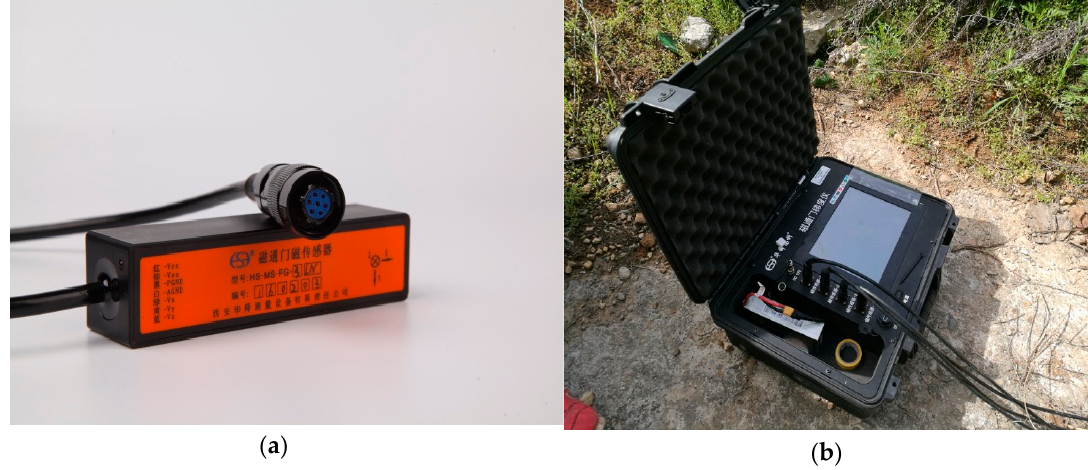
Figure 15. ( a ) Three-component fluxgate sensor of HS-MS-FG-3-LN; ( b ) Data acquisition card of NI 9239.